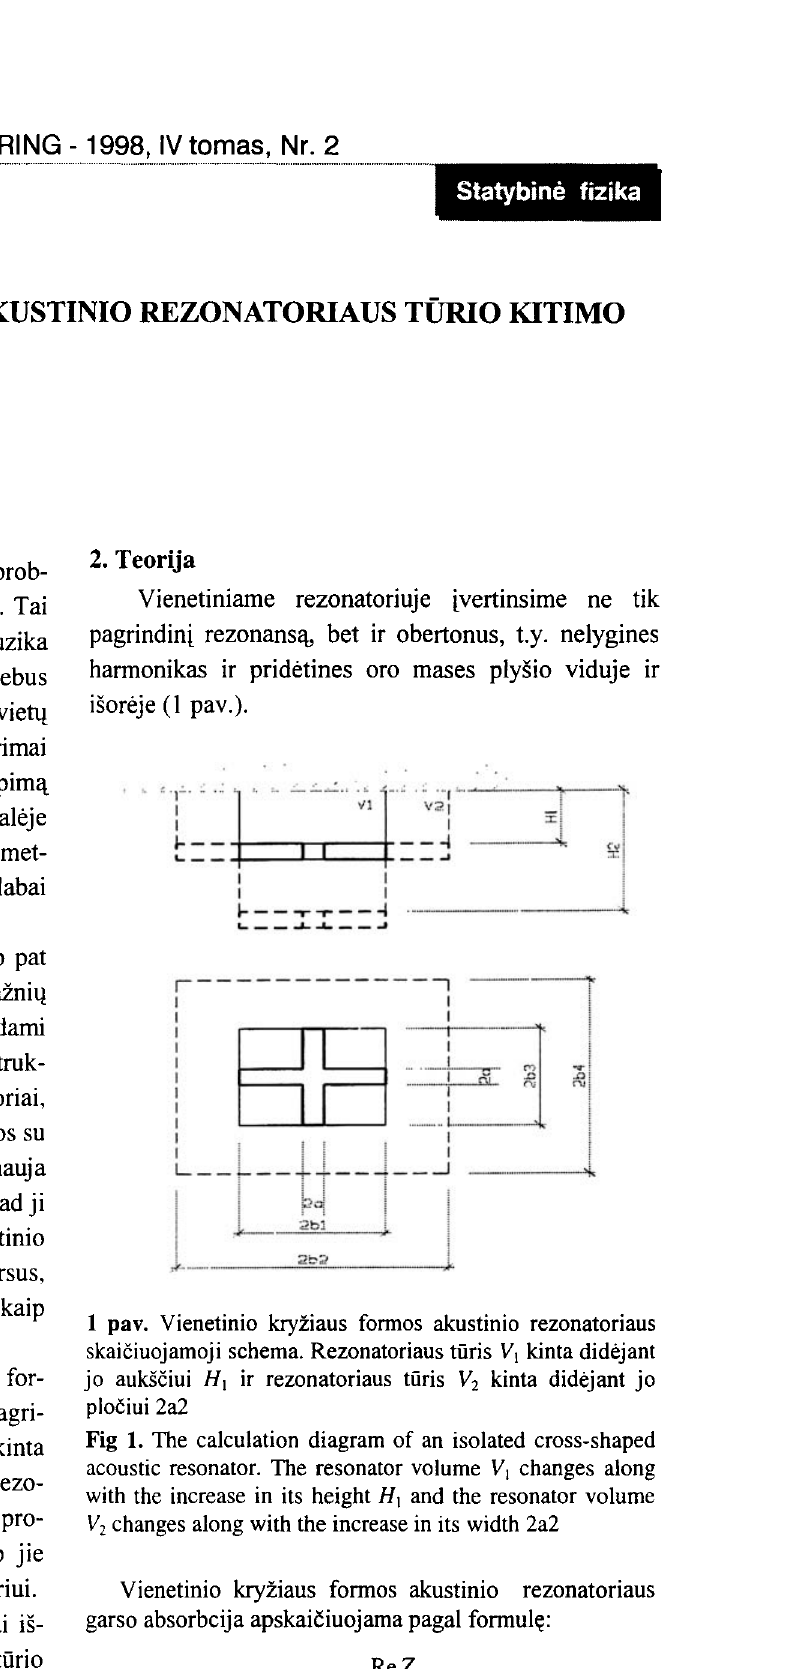
cia p oro tankis; c garso greitis ore; Sr- rezona 0 - 0 - toriaus plotas; Zr - rezonatoriaus spinduliavimo impe dansas; Zm - paties plysio